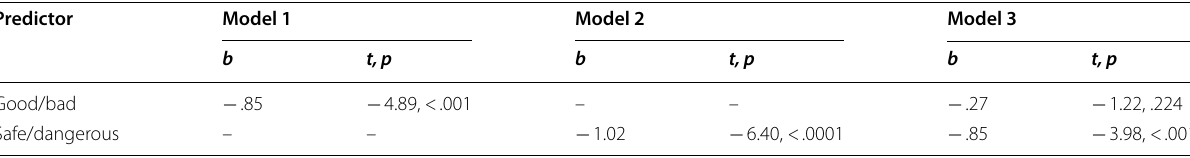
b represents unstandardized regression coefficients